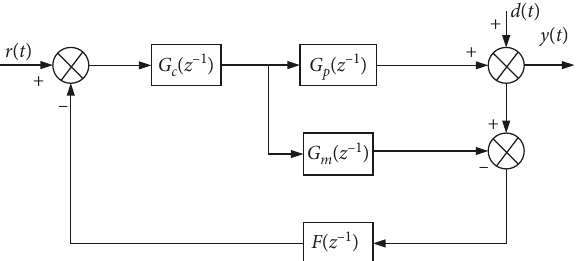
Figure 2: The principle structure of internal model